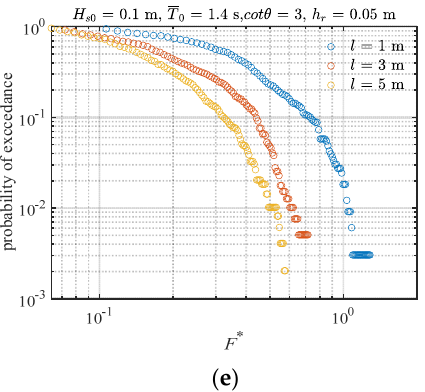
Figure 26. Probability of exceedance of irregular wave force on the vertical seawall for different cases: ( a ) H s 0 ; ( b )